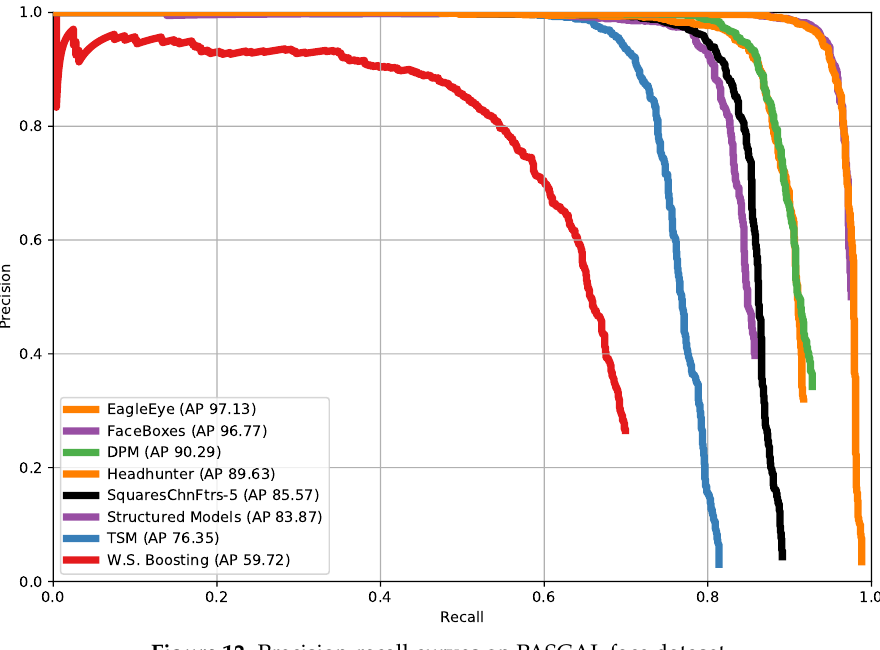
Figure 12. Precision-recall curves on PASCAL face dataset.